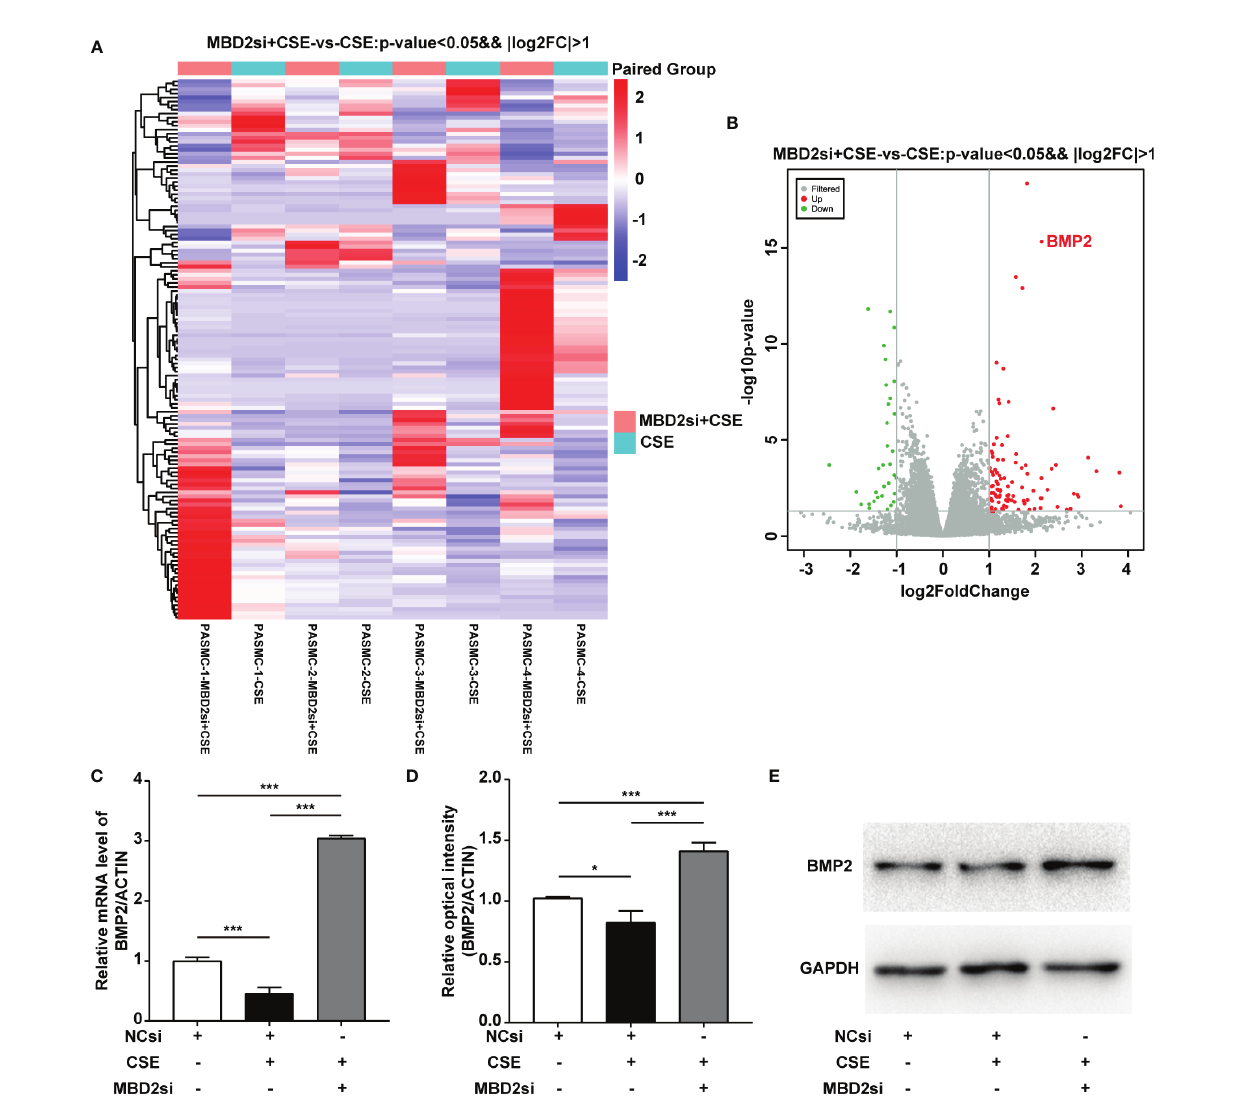
FIGURE 5 | MBD2 can in fl uence downstream BMP2 expression. (A, B) MBD2si induced changes in downstream genes as investigated by RNA-seq. MBD2si + CSE vs CSE, n=4, P < 0.05, |log2FC| > 1. (C) Quantitation of the BMP2 mRNA expression in HPASMCs transfected with negative control siRNA (NCsi) or MBD2si, stimulated with 2% CSE or control solvent for 24h. The subsequently divided groups are the same. (D) Quantitation of the BMP2 bands based on the density. (E) Representative Western blot images of BMP2 in HPASMCs. The data are presented as mean ± SD, n=3. * P < 0.05, *** P <